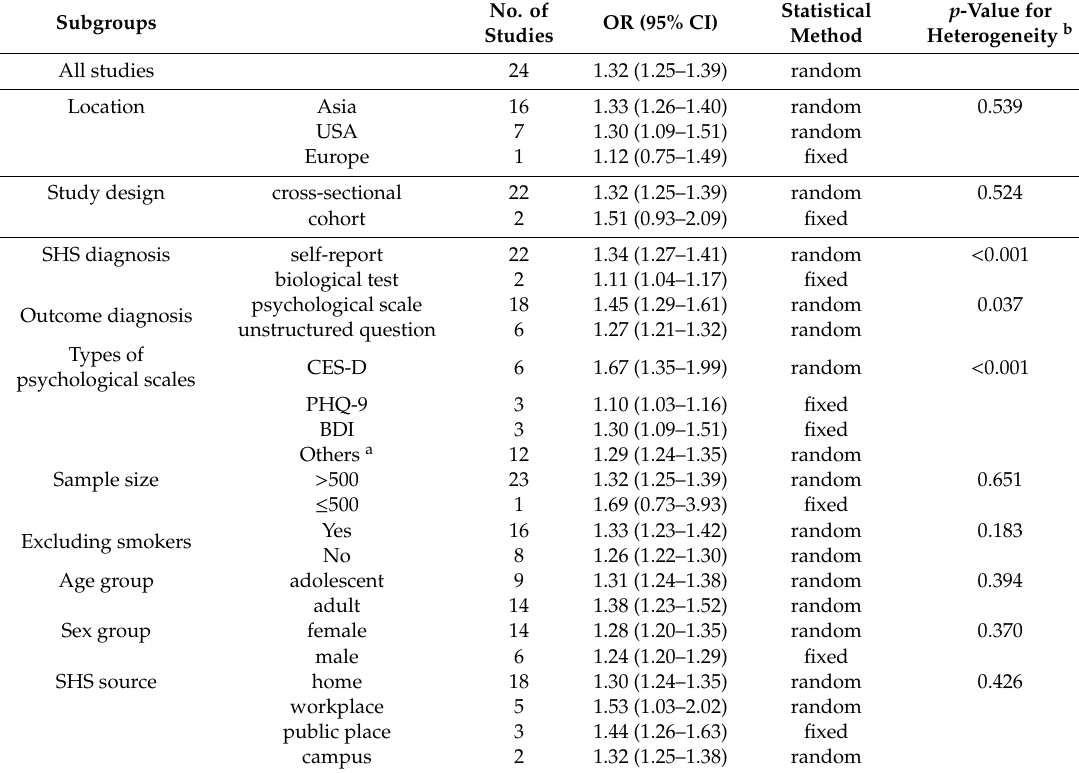
Table 2. Pooled ORs of depressive symptoms in strata of selected